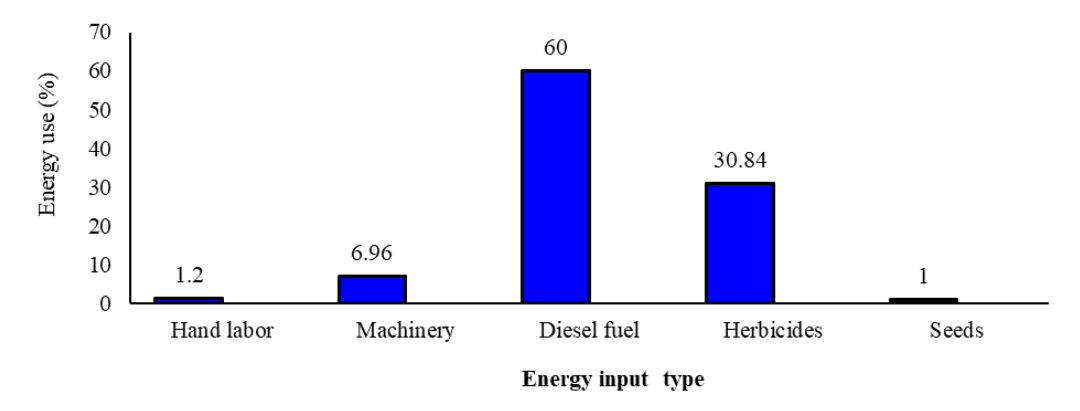
Fig. 1. The shares of energy inputs for sunflower